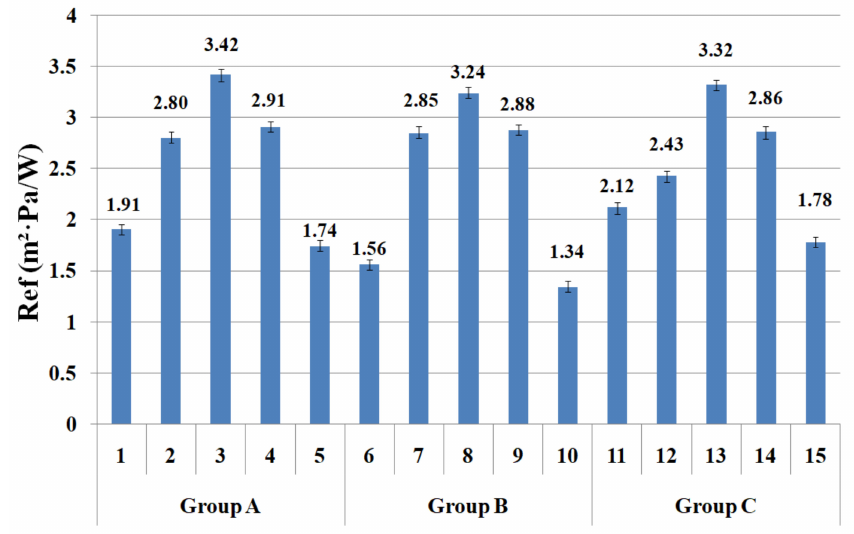
Figure 6. R ef of the specimens using the ISO 11092